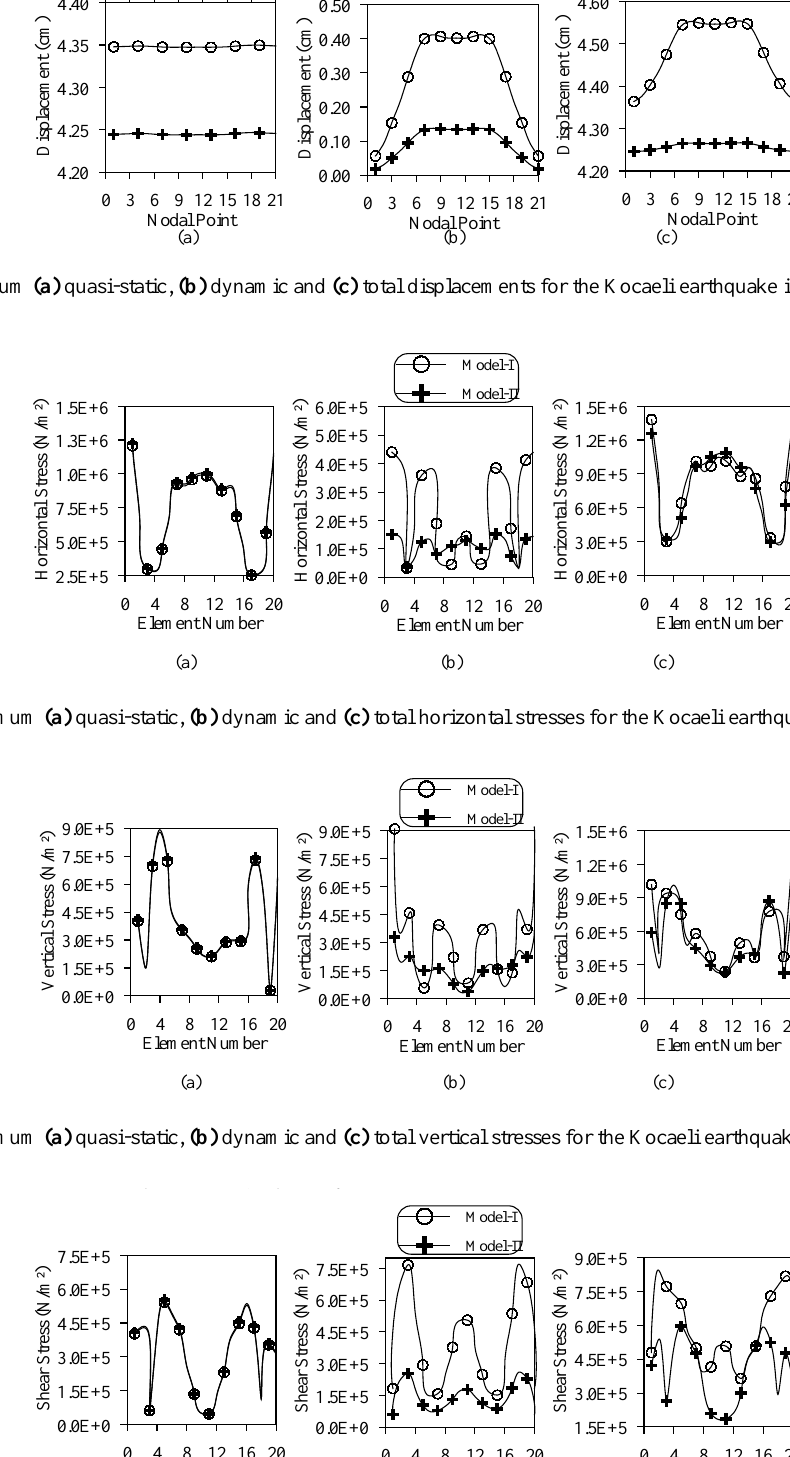
Fig. 12. Mean of maximum (a) quasi-static, (b) dynamic and (c) total shear stresses for the Kocaeli earthquake in 1999, respectively. Nat. Hazards Earth Syst. Sci., 12, 1151–1157,